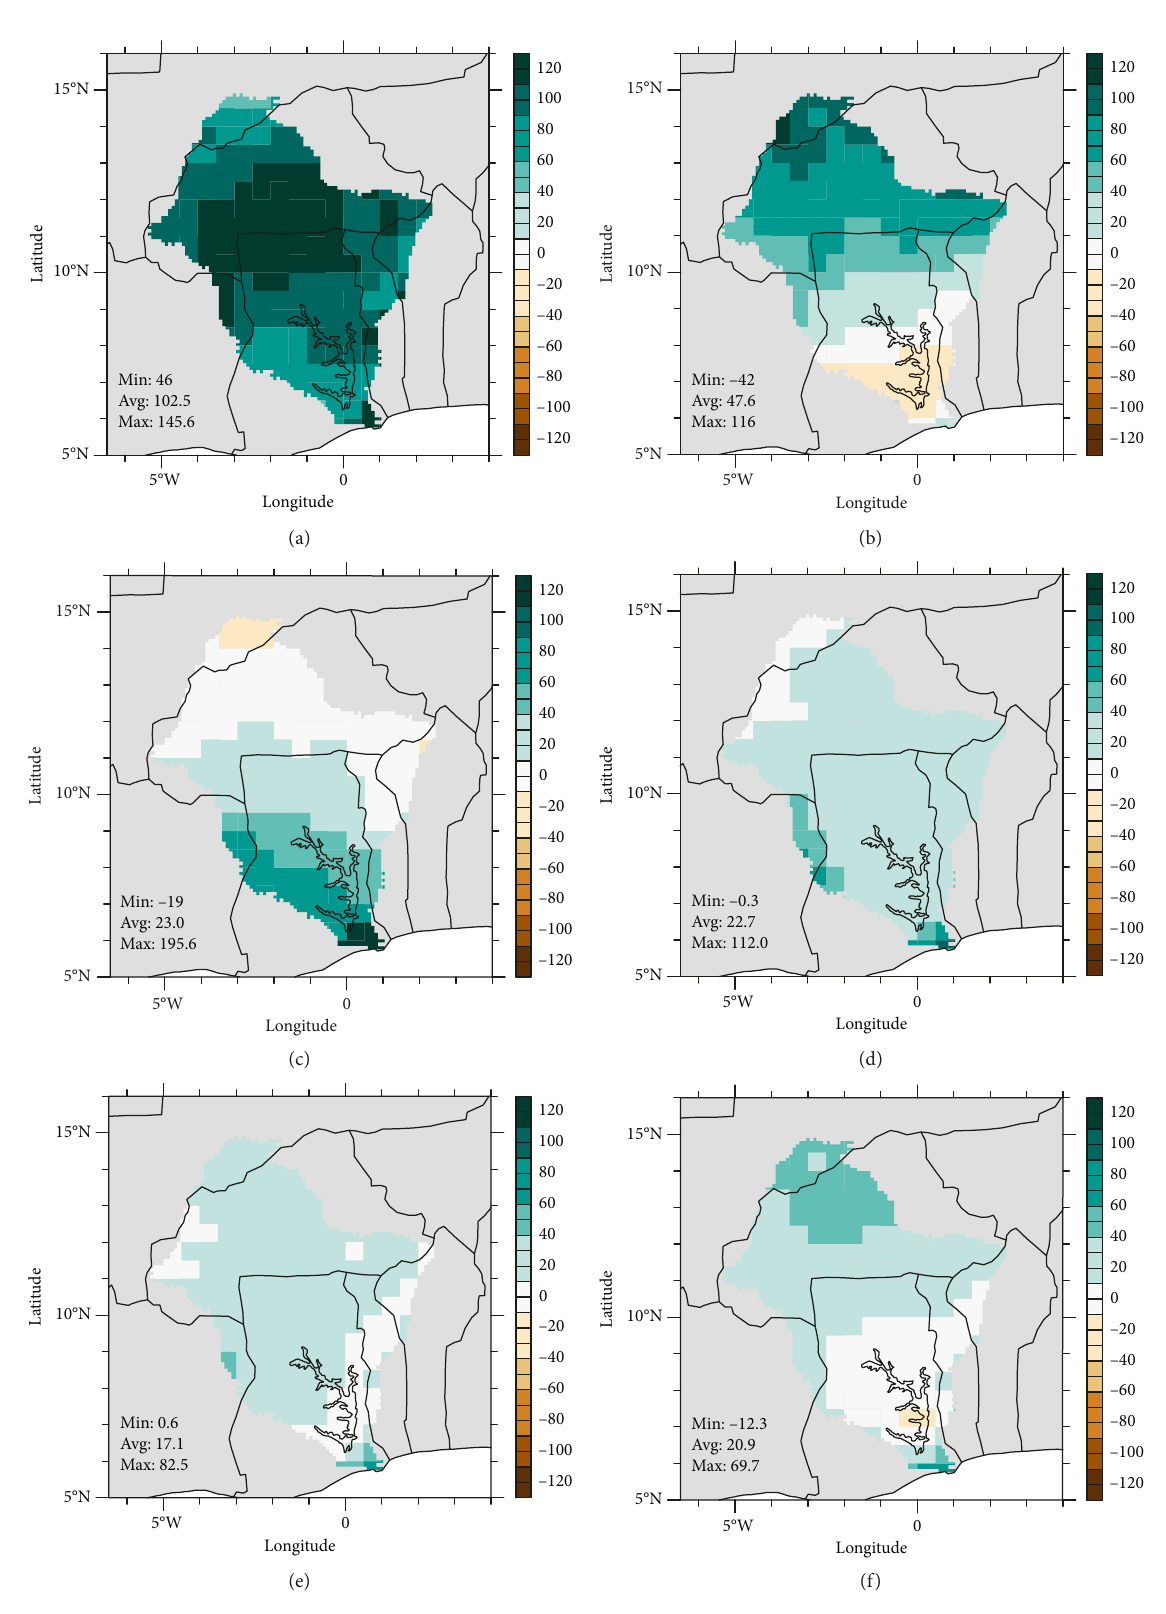
Figure 2: The climatological (1950–2004) mean bias in the annual total precipitation for the models: MIROC5 (a), CSIRO-Mk3.6.0 (b), MIROC-ESM (c), CNRM-CM5 (d), CanESM2 (e), and EC-EARTH (f), overestimating the observed climatological mean over major parts of the Volta